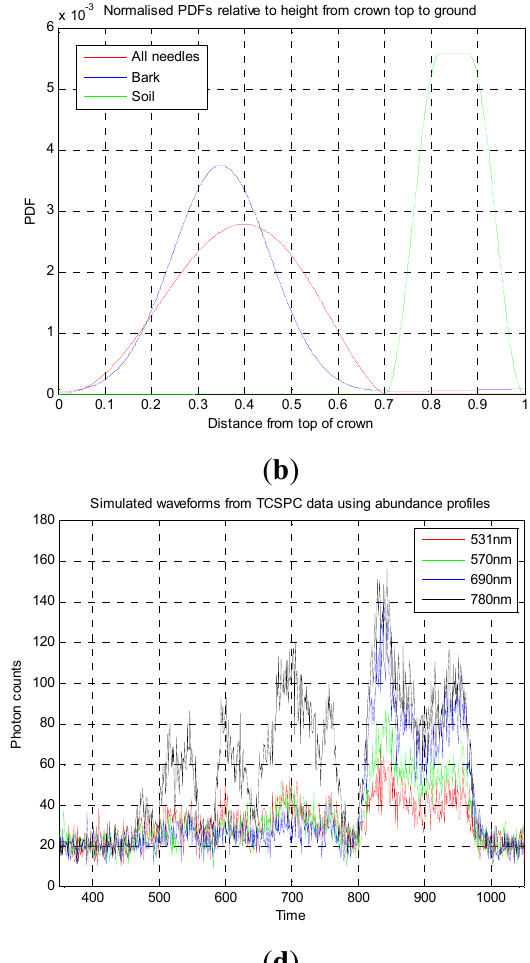
Figure 7. ( a ) Assumed distribution of current, first year, and older leaves using published data. ( b ) Normalised distributions of leaf bark and soil used in the simulations ( c ) Resulting C profile using previous data ( d ) Example of generated multispectral signature with ab added